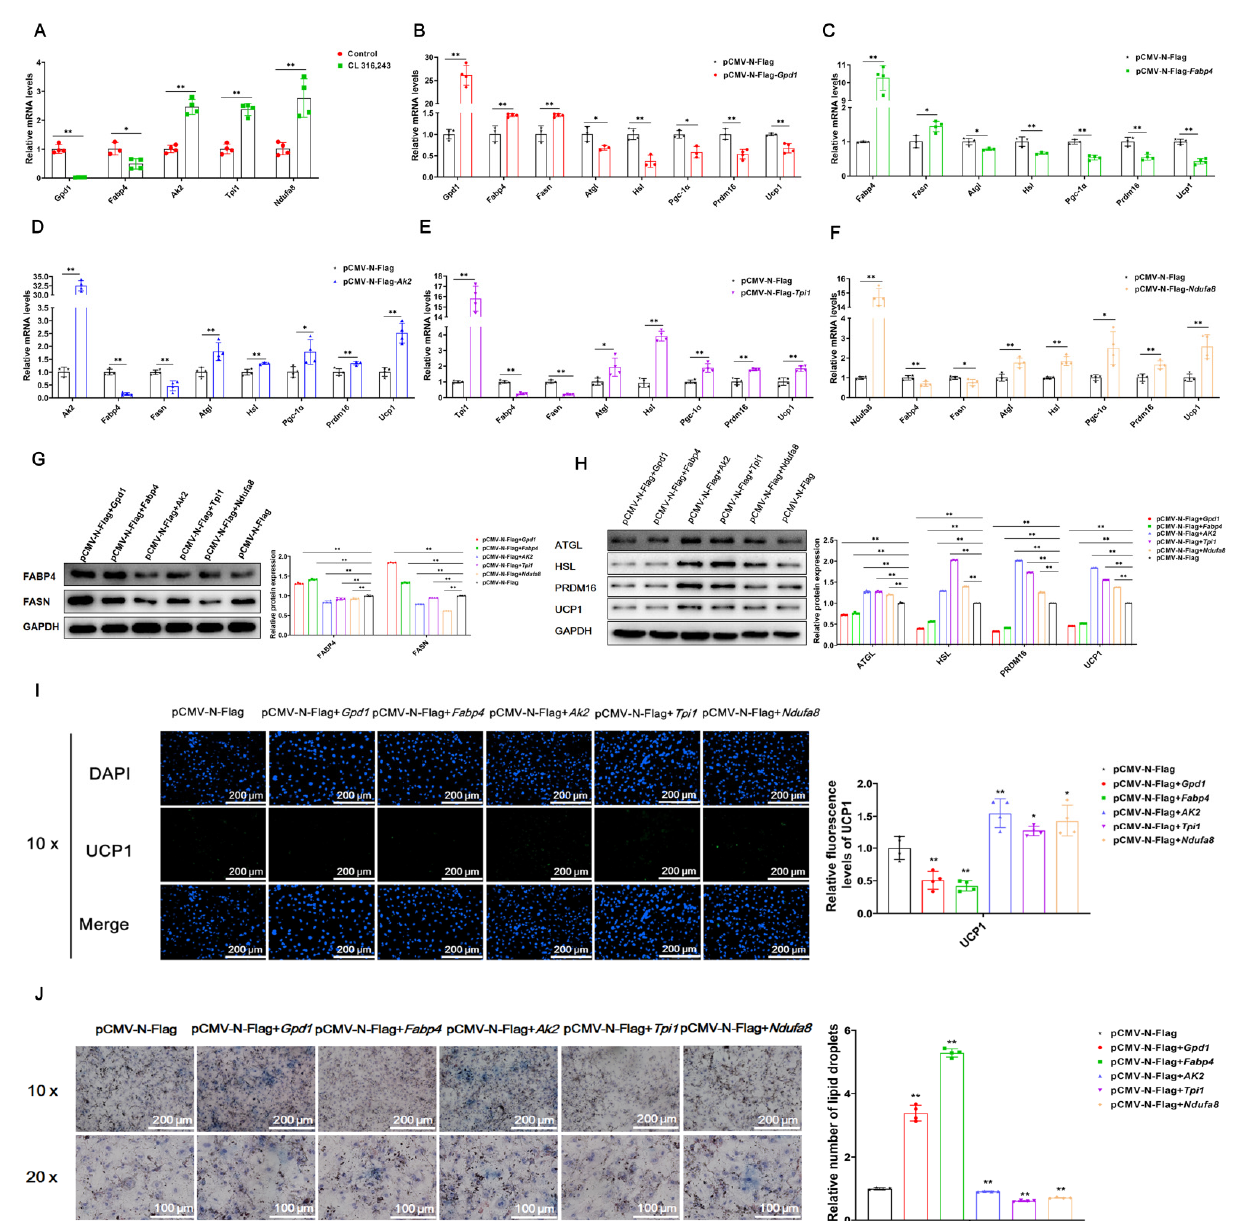
Figure 4. Gpd1 and Fabp4 inhibit white adipocyte browning, while Ak2, Tpi1 and Ndufa8 promote white adipocyte browning. Note: 3T3-L1 adipose precursor cells were induced to differentiate into mature adipocytes, and the constructed overexpression vector was transferred into adipocytes. Cellular RNA and protein were extracted after 24 h and 48 h, respectively. The expression efficiency of genes; the relative expression levels of lipid synthesis-related genes Fabp4 and Fasn; the relative expression levels of lipolysis genes Atgl and Hsl; and the relative expression levels of white fat browning-related genes Pgc-1 α , Prdm16 and Ucp1 were detected. ( A ) After CL316,243 treatment of mice, the relative expression levels of each target gene mRNA ( n = 4). ( B – F ) The relative mRNA expression levels of genes related to expression efficiency, lipid synthesis, lipolysis and white fat browning after overexpression of Gpd1, Fabp4, Ak2, Tpi1 and Ndufa8 ( n = 4). ( G , H ) Relative protein expression levels of lipid synthesis-, lipolysis- and sebaceous browning-related proteins after overexpression of Gpd1, Fabp4, Ak2, Tpi1 and Ndufa8 ( n = 3). ( I ) Immunofluorescence staining and quantification of Ucp1 after overexpression of Gpd1, Fabp4, Ak2, Tpi1 and Ndufa8, scale bar: 200 µ m ( n = 4). ( J ) Oil Red O staining after overexpression of Gpd1, Fabp4, Ak2, Tpi1 and Ndufa8, scale bar: 200 µ m ( n = 4). Values are mean ± SD compared to the control group, * p < 0.05, ** p <